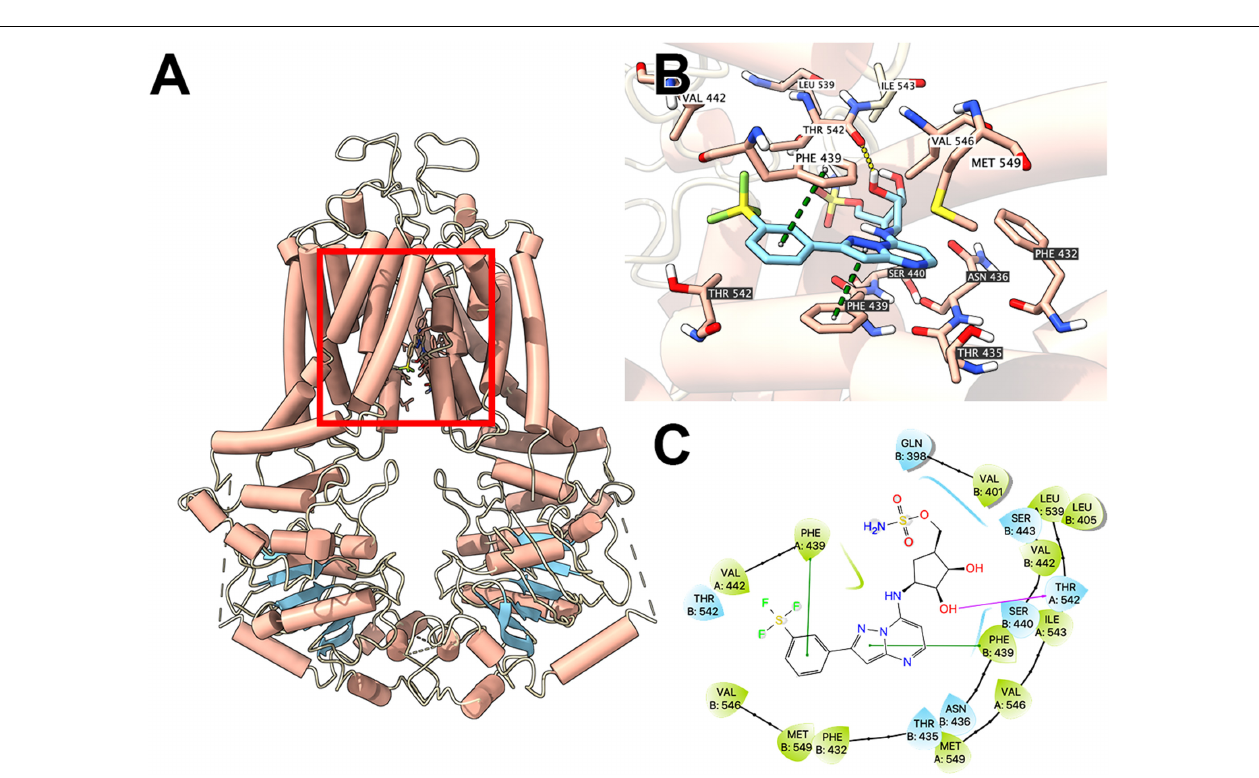
FIGURE 4 | Interaction between MLN7243 and human ABCG2 protein model. (A) Overview of the best-scoring pose of MLN7243 in the drug binding pocket of ABCG2 protein (6VXI). ABCG2 was displayed as colored tubes (helix: red; strand: blue; coil: white). MLN7243 was displayed as colored sticks. Carbon: cyan; oxygen: red; nitrogen: blue, hydrogen: white. (B) Details of the interaction between MLN7243 and ABCG2 binding pocket. ABCG2 helices were displayed as colored tubes (helix: red; strand: blue; coil: white). Important residues were displayed as colored sticks (carbon: red; oxygen: red; nitrogen: blue; hydrogen: white). MLN7243 was displayed as colored sticks (same as in A). Residues in chain A and B was labeled on white and black background, respectively. Hydrogen bonds were displayed as yellow dash lines. π − π stacking interactions were displayed as green dash lines. (C) 2D diagram of the interaction between MLN7243 and ABCG2 binding pocket. Important amino acids within 3 Å from the ligand were displayed as colored bubbles (green: hydrophobic; blue: polar). Purple solid lines with arrow indicate hydrogen bonds. Green solid lines indicate π − π stacking